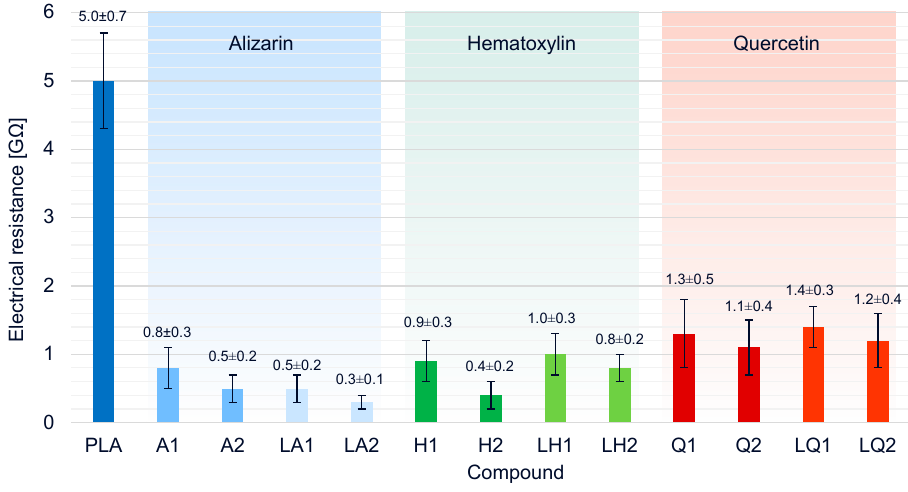
Figure 11. Electrical resistances of pure PLA and PLA / dye compounds.